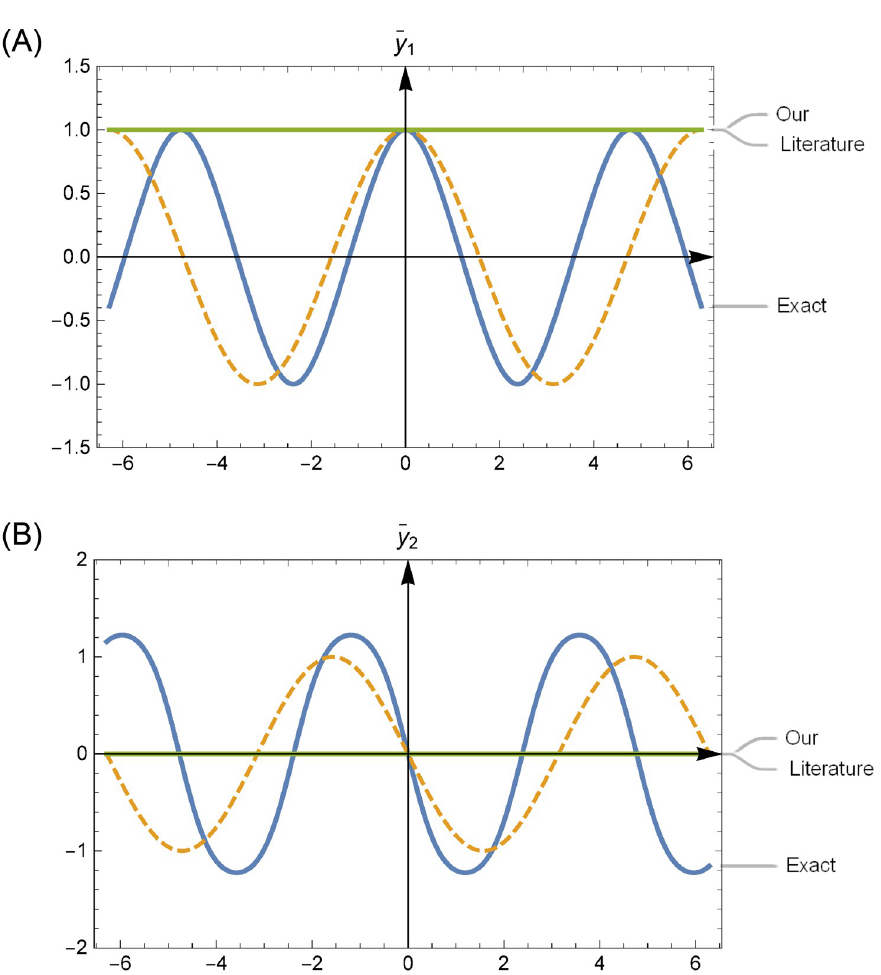
Fig 9. Comparison of the approximate efficiencies of first terms � y t = 0 in Example 3. A:Comparison of � y t =